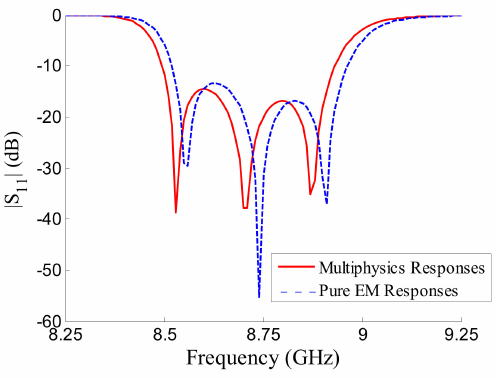
Figure 9. Comparison of the multiphysics output responses and pure EM output responses with the same geometrical parameters for the three-pole waveguide filter.